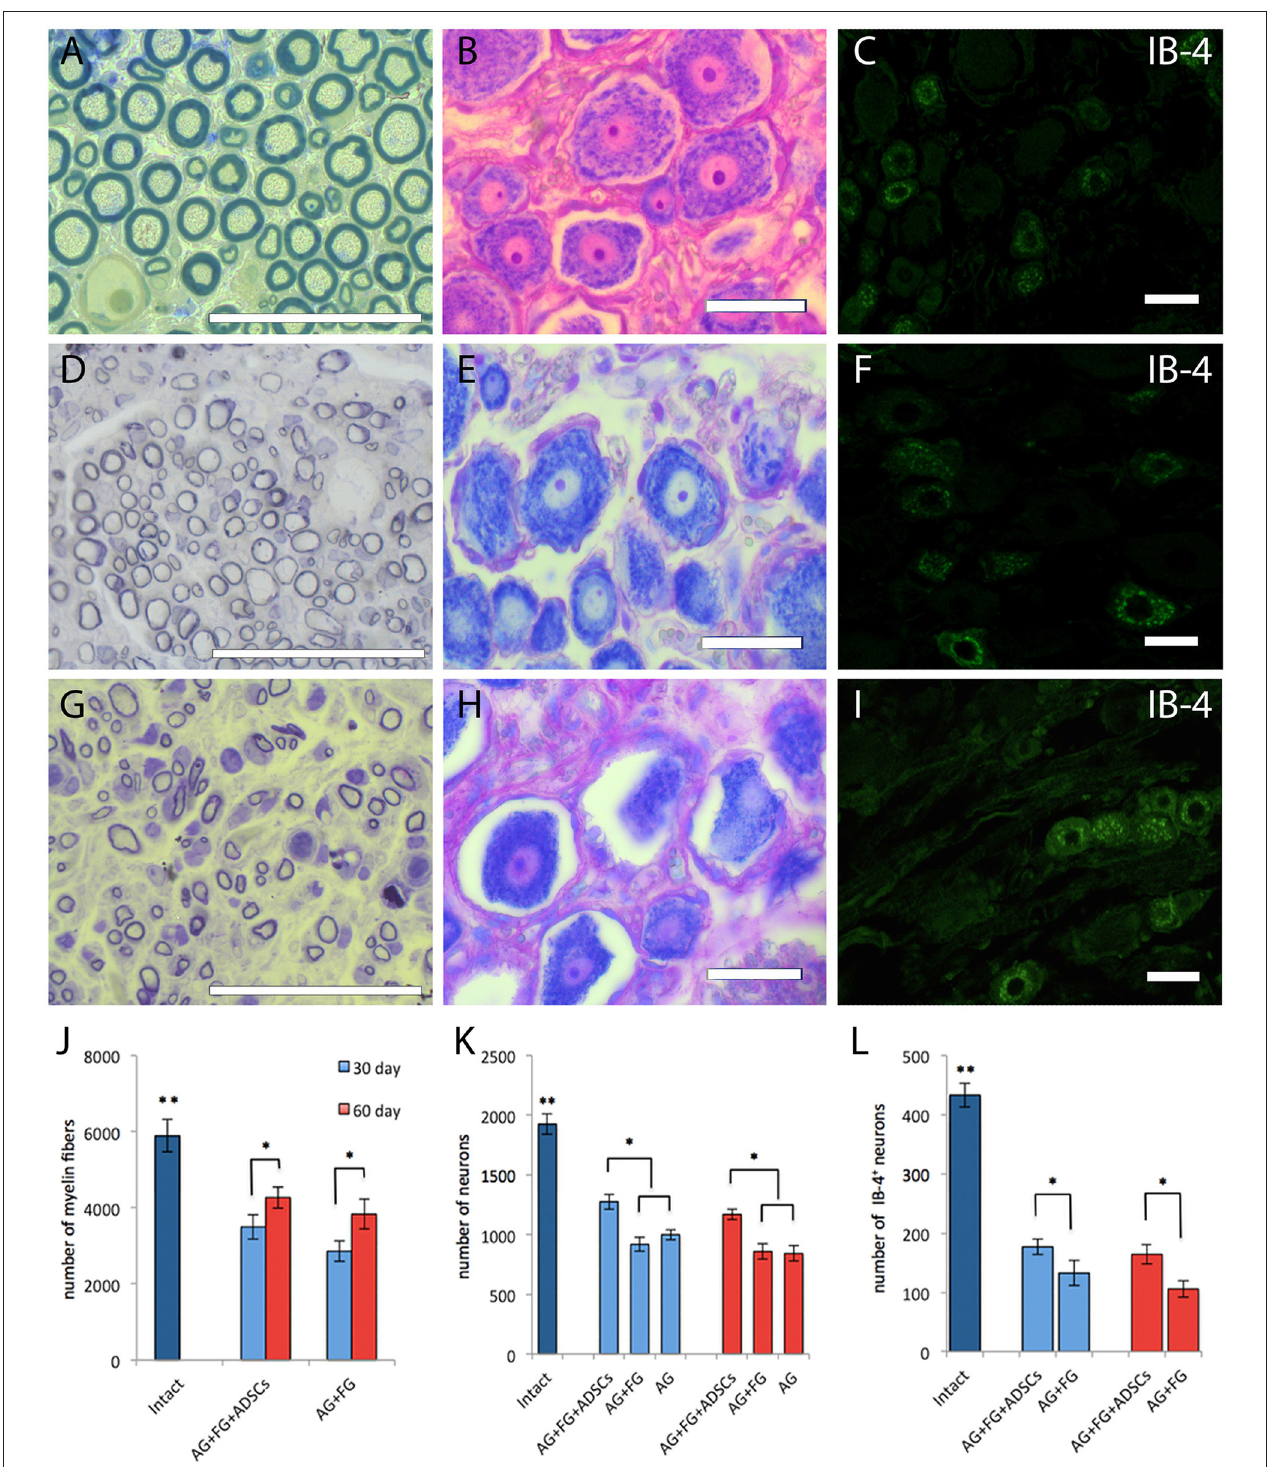
FIGURE 8 | Morphology and number of fibers and neurons in intact and transplanted animals. Top line (A–C) , intact animals; second line (D–F) , AG + FG + ADSCs group 30 days after the injury; third line (G–I) , AG + FG group 30 days after the injury. Scale bar scale 50 µ m. (A,D,G) Light microscopy images of myelinated fibers fixed in osmium and stained by methylene blue. (B,E,H) Light microscopy images of L5 DRG neurons stained by azure-eosin. (C,F,I) Confocal microscopy images of IB-4 + neurons stained with the fluorescent cytoplasmic marker Isolectin-B4 [lectin from Bandeiraea simplicifolia (BSi-B4)]. (J) Number of myelin fibers in the distal stump of the sciatic nerve; (K) Number of L5 DRG neurons; (L) Number of IB-4 + neurons L5 DRG. Differences were statistically significant between the groups (*) between experimental groups, (**) between intact and experimental groups (* , **- P < 0.05, one-way ANOVA, Tukey’s test).